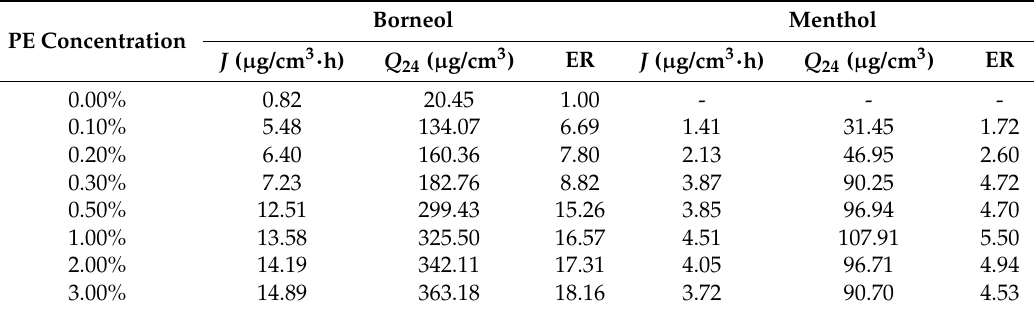
Table 1. Permeation parameters of 5-fluorouracil (5-FU) across rat skin at various concentration of borneol and menthol.